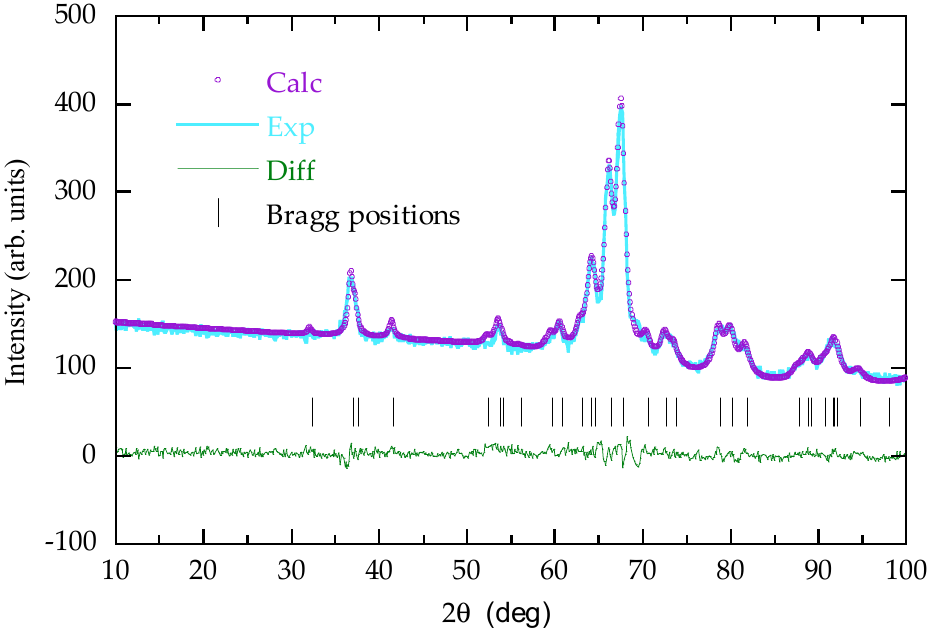
Figure 3. Rietveld refinement plot for the neutron powder diffraction pattern collected at 300 K. The cyan solid line in the upper field represents the observed intensity data, while the calculated pattern is superposed and drawn as purple empty dots. The small black vertical bars indicate the positions of the allowed Bragg reflections for the orthorhombic phase. The difference between the observed and calculated patterns is plotted in the lower field as a green solid line. Rietveld discrepancy values are R-profile R p = 2.7 %, R-weighted profile R wp = 3.4%, goodness-of-fit GoF (i.e., χ 2 ) = 1.3, R-Bragg R B = 3.4%.